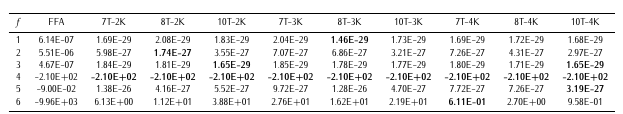
Table 4. Results: 20 fireflies and Crossover with the K best threads